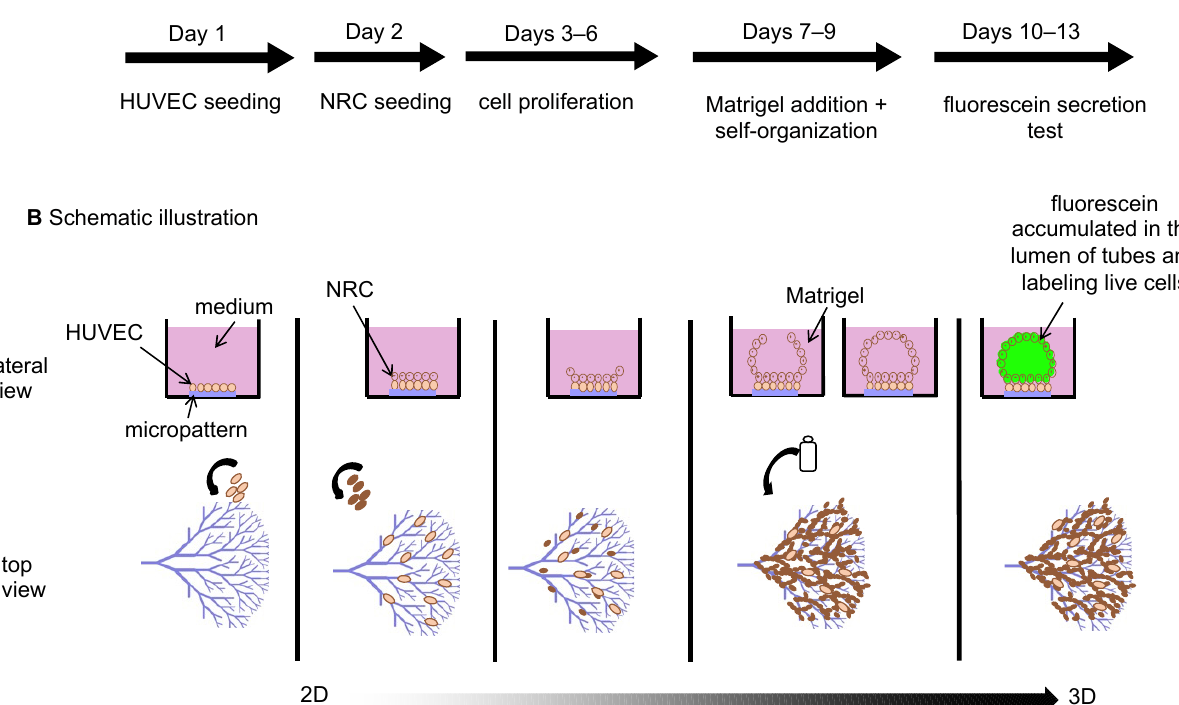
Figure 1. Experimental workflow of biliary tube engineering based on 2D micropatterning and 3D growth stimulation. ( A ) cell culture protocol: day 1 to day 6: cell seeding and cell proliferation in 2D on micropatterns, Matrigel addition, and self-organization from days 7 to day 10/13 in 3D. A fluorescein secretion test was performed on day 10/day 13 to reveal the formation of lumens. ( B ) schematic illustration of the lateral and top views of the experimental setup.